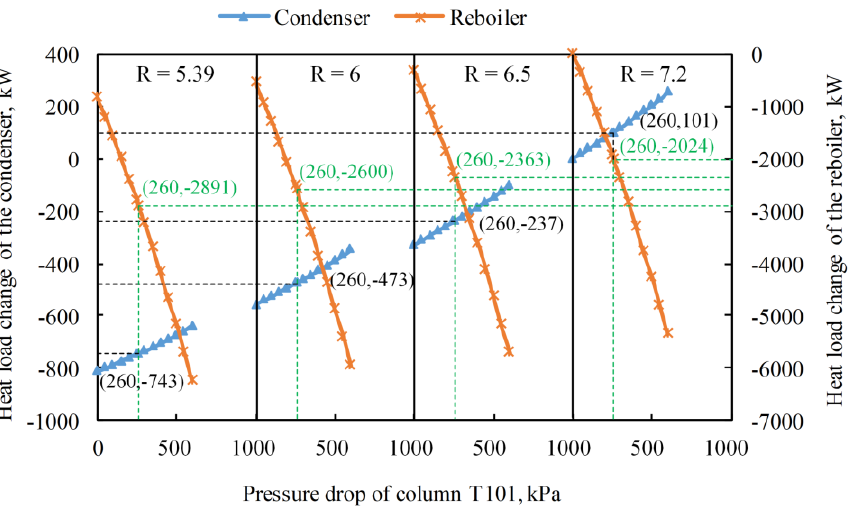
Figure 12. Heat load changes of condenser and reboiler under different reflux ratios and operating